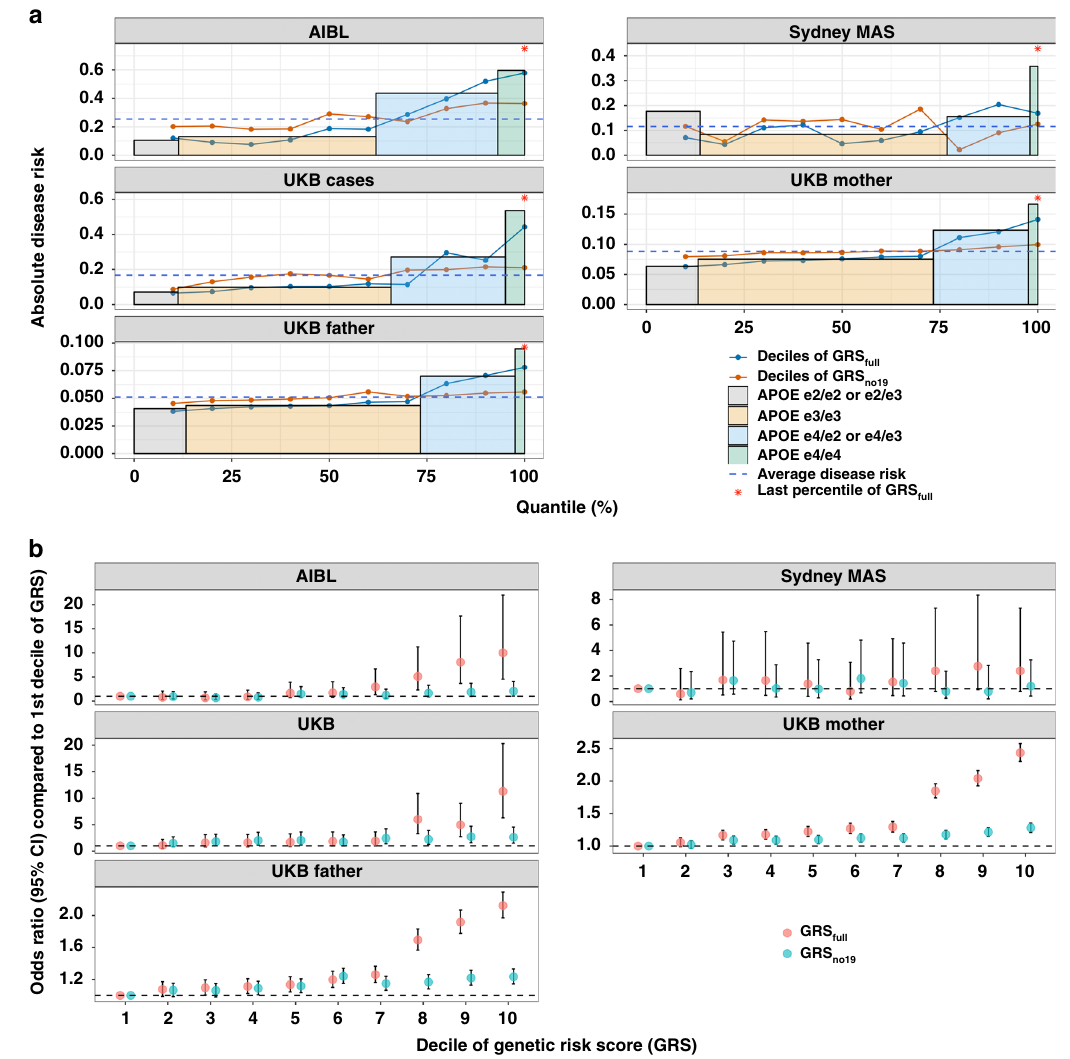
Fig. 4 The comparison of LOAD prediction performance between GRS and APOE . a The disease risk of late-onset Alzheimer ’ s disease of individuals in different deciles of GRS (both GRS full and GRS no19 ), last percentile of GRS full and in individuals with APOE ɛ 2/ ɛ 2 or ɛ 2/ ɛ 3, APOE ɛ 3 homozygotes ( ɛ 3/ ɛ 3), APOE ɛ 4 heterozygotes ( ɛ 4/ ɛ 3 or ɛ 4/ ɛ 2) and APOE ɛ 4 homozygotes ( ɛ 4/ ɛ 4). Samples from AIBL, Sydney MAS, UKB cases, UKB mother and UKB father were examined. b Odds ratio between individuals in the other deciles and fi rst decile of GRS. GRS full was calculated based on 1,056,154 HapMap3 SNPs and two APOE SNPs. GRS no19 was calculated based on HapMap3 SNPs but excluding SNPs from chromosome 19. Only independent ( R 2 < 0.01) SNPs with P < 1 × 10 − 8 were used to calculate the GRS. The error bars in b represent 95% con fi dence